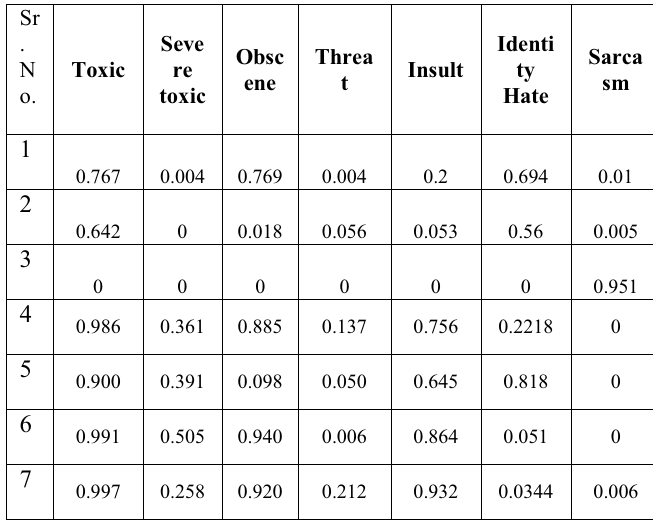
Table 3. Tweets selected to test LSTM model.